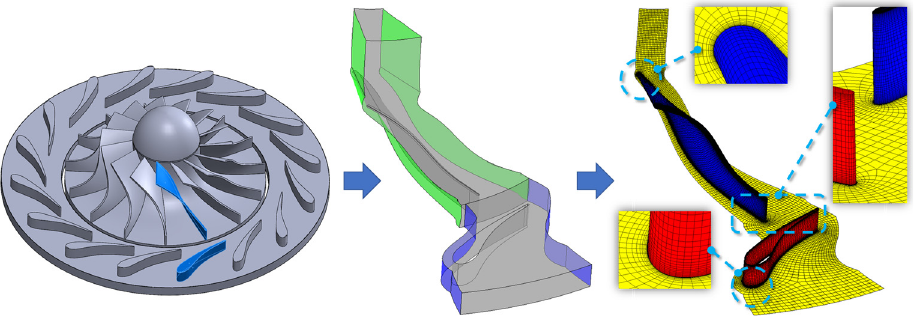
Figure 4. 3-D numerical model and grids.